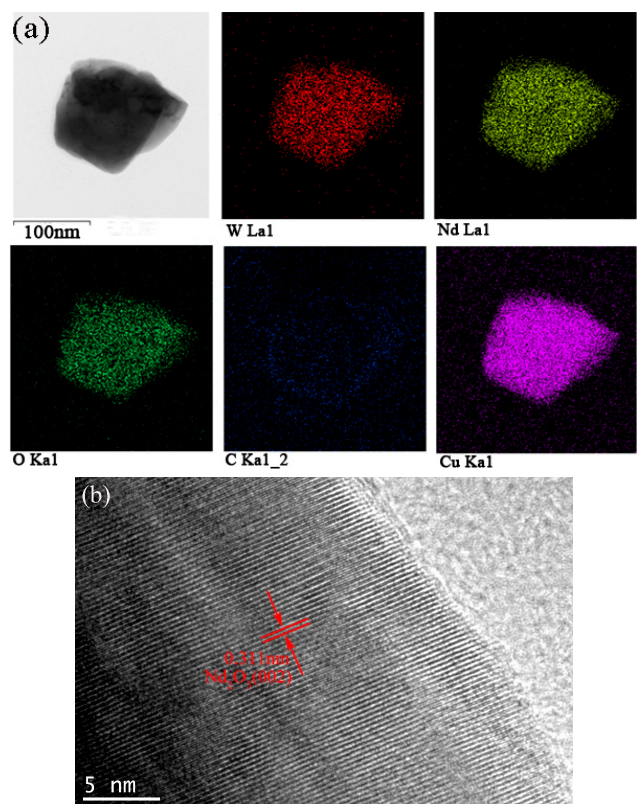
Figure 4. Transmission electron microscopy (TEM) images of the as-synthesized W–1 wt % Nd 2 O 3 powders. ( a ) Energy dispersive X-ray spectroscopy (EDS) mapping images showing elemental distributions; ( b ) High-resolution transmission electron microscopy (HR-TEM) image showing the interplanar crystal spacing.